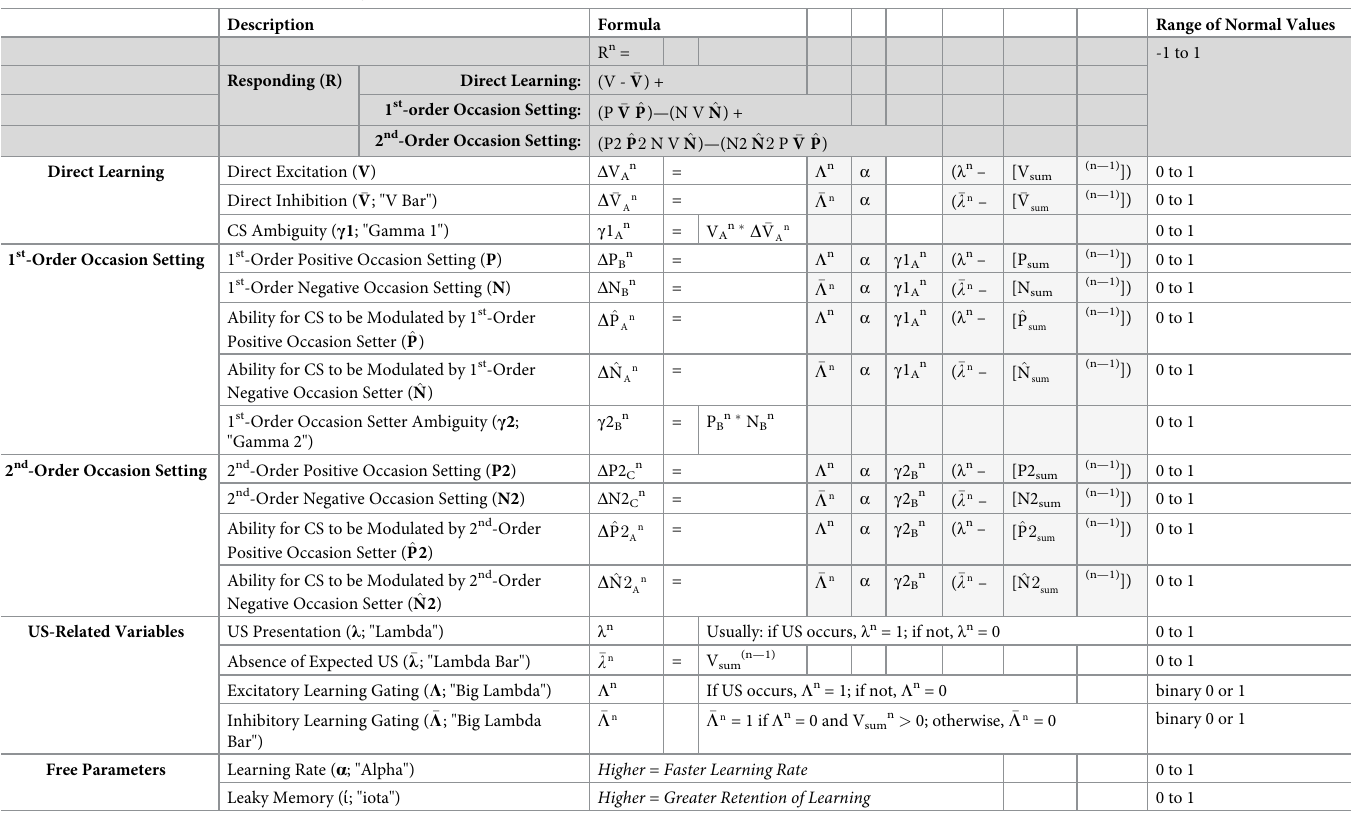
Table 3. Formulas for Learning Direct Learning, 1 st -Order Occasion Setting, and 2 nd -Order Occasion Setting. In the table, subscripts are stimulus names (e.g., A, B, C; "sum" for all stimuli present on a trial); superscripts are trial numbers. For "R" formula, superscript "n" for all variables, and subscript "sum" for all variables except "R.” Formulas are arranged in column format for readability. Responding (R) formula ultimately predicts behavioral responding and learning. R operates by adding excitation and subtracting inhibition (formula in dark gray). Light gray columns highlight the similar variables used in the "recipe" across our learning formulas. Hierarchical